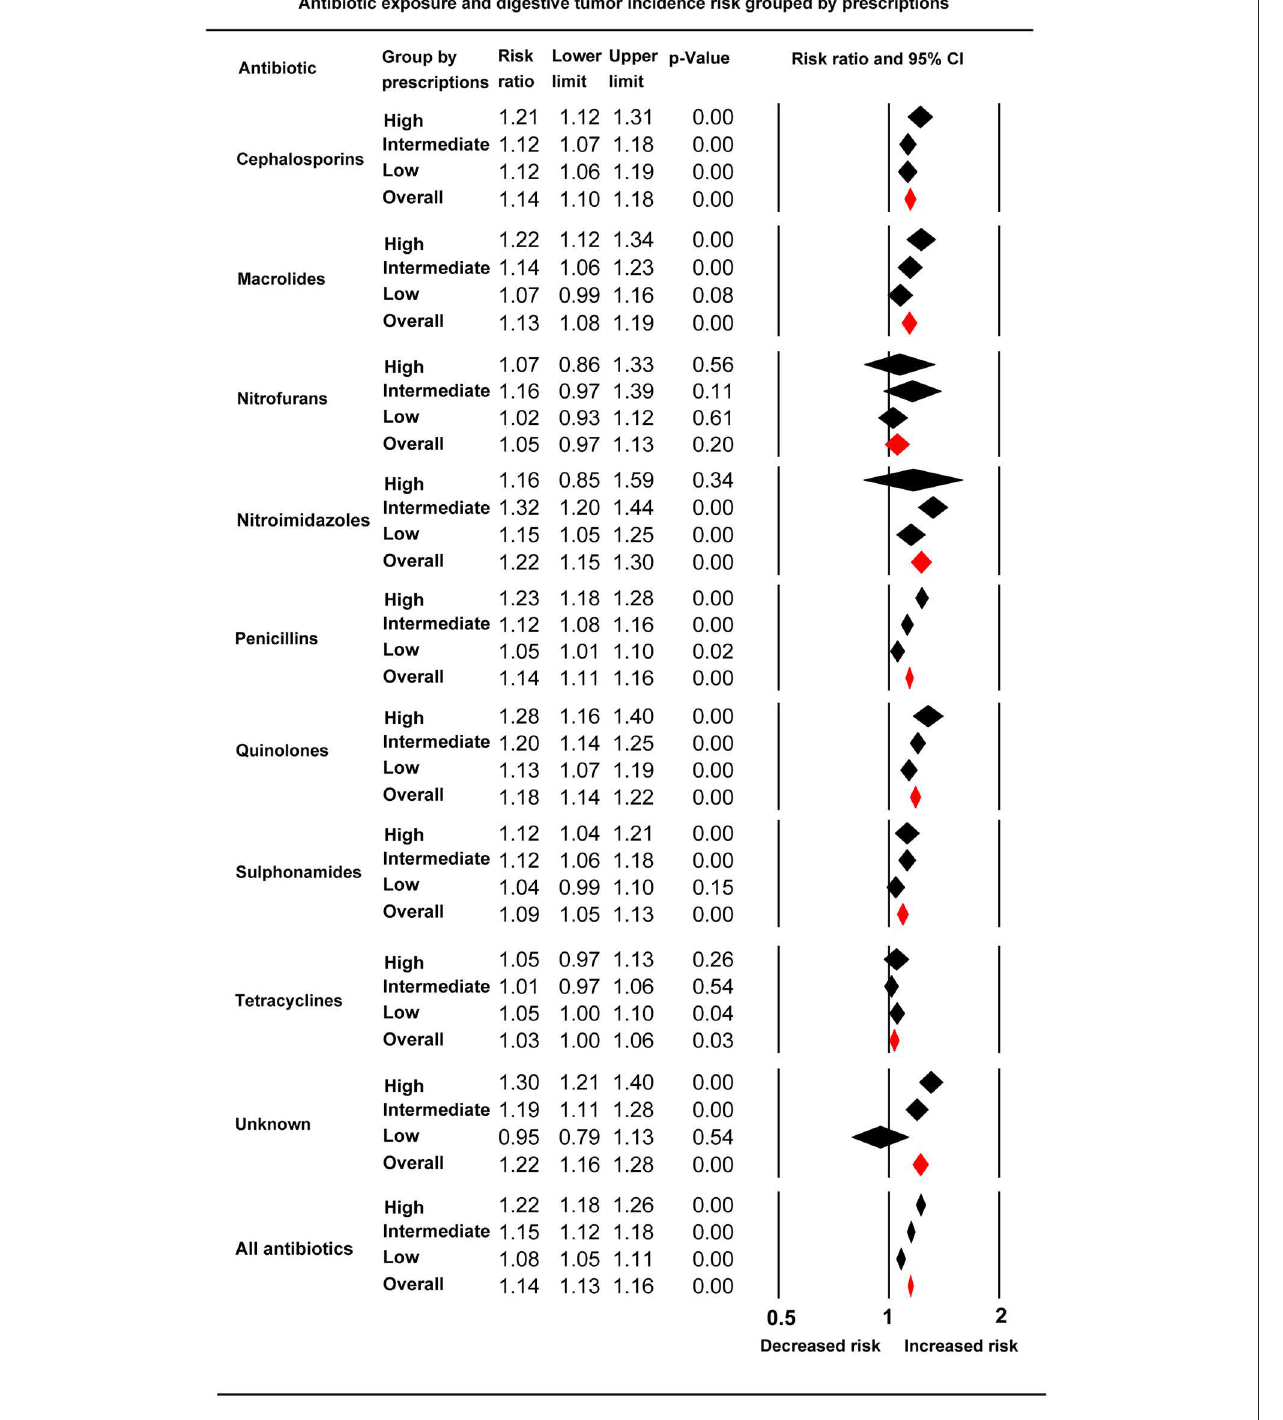
as phytochemicals, into bioactive compounds (51, 61). Anti-bacterial drug exposure reduces the composition and diversity of the intestinal microbiota, predominately composed